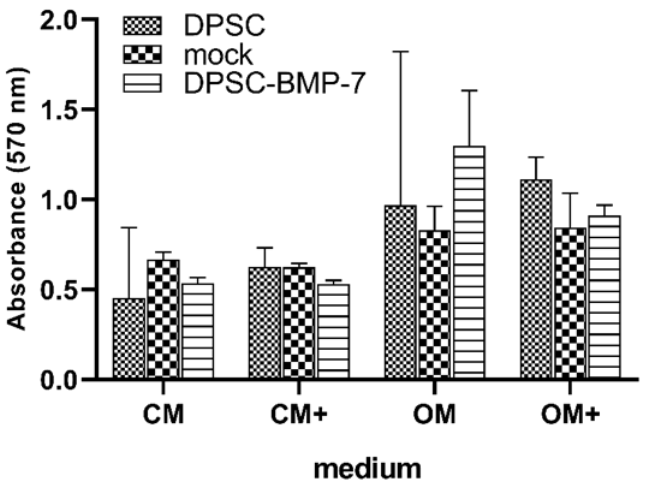
Figure 5. Mineralization of the indicated cell lines grown for 3 weeks in different media. Cells were stained and alizarin red levels taken were quantified with the use of cetylpyridinium chloride at 570 nm. *, p < 0.05 vs. control (DPSC) in the same media, #, p < 0.05 vs. untreated (CM or OM respectively) group of the same cell line.